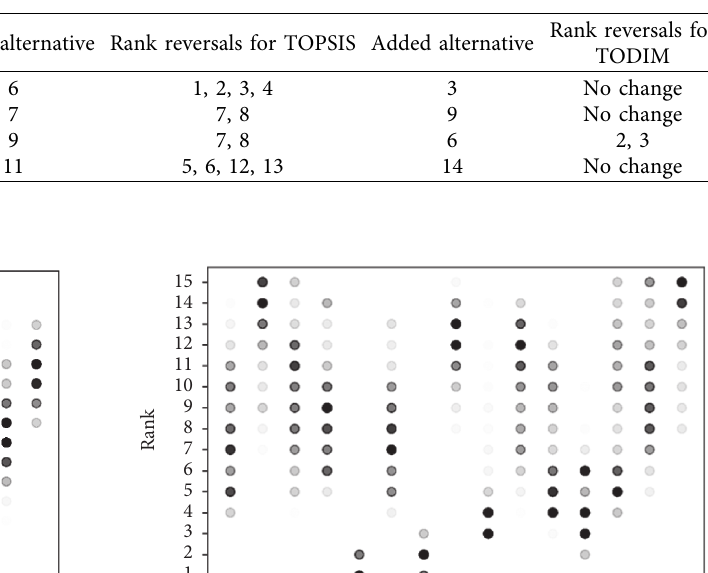
Table 18: Comparison of rank reversal results of NR-TOPSIS, TOPSIS, and TODIM when one alternative is removed from the new list of batsmen.